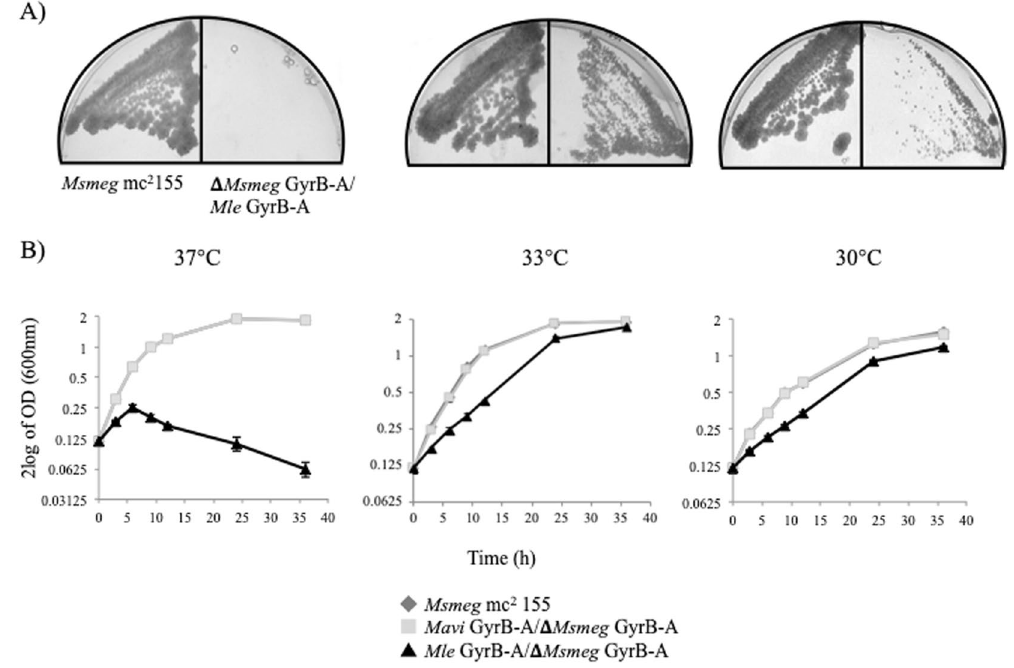
Figure 6. Growth of recombinant Msmeg strains relative to the parental strain mc 2 155. ( A ) Approximately 1 × 10 3 bacterial cells were spread on 7H10 agar plates and incubated at 30 °C, 33 °C, and 37 °C. Left and right panels are Msmeg mc 2 155 and recombinant Msmeg with Mle GyrB-GyrA, respectively. ( B ) Growth rate of parental and recombinant mutants; ◆, ■ , and ▲ indicate Msm eg mc 2 155, Msmeg with DNA gyrB-gyrA exchanged for Mavi gyrB-gyrA genes, and Msmeg with DNA gyrB-gyrA exchanged for Mle gyrB-gyrA genes.